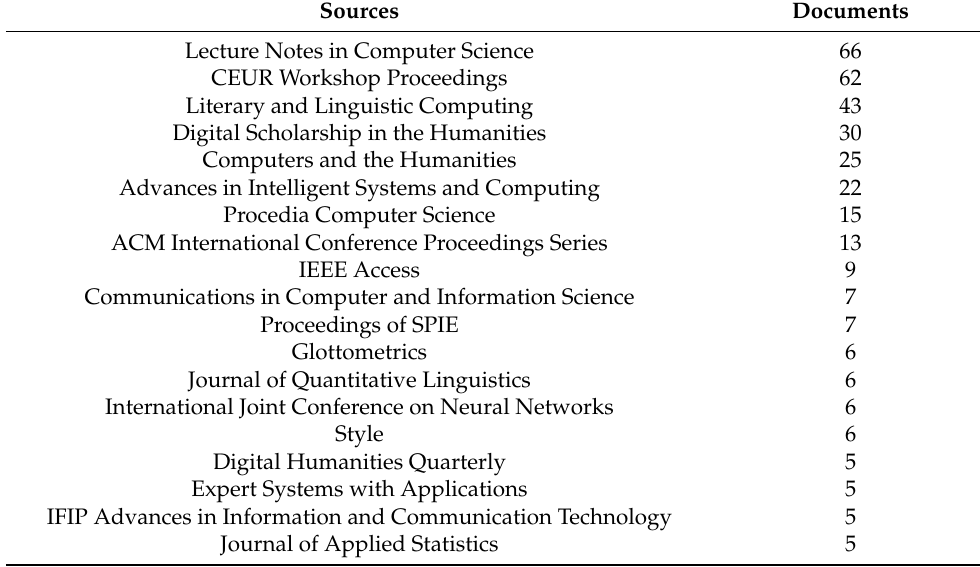
Table 2. Most productive